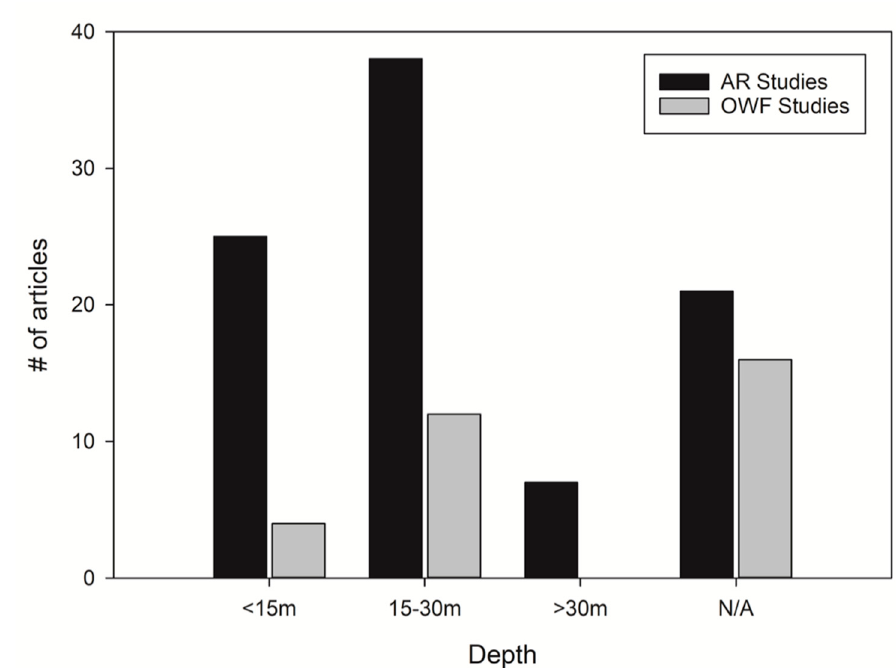
Figure 6. Mean water depths of artificial reef (AR) and offshore wind farm (OWF) structures. Some papers are included in multiple categories, because they studied more than one structure, located at different water depths. “N/A” means that the water depth was not specified in the articles.